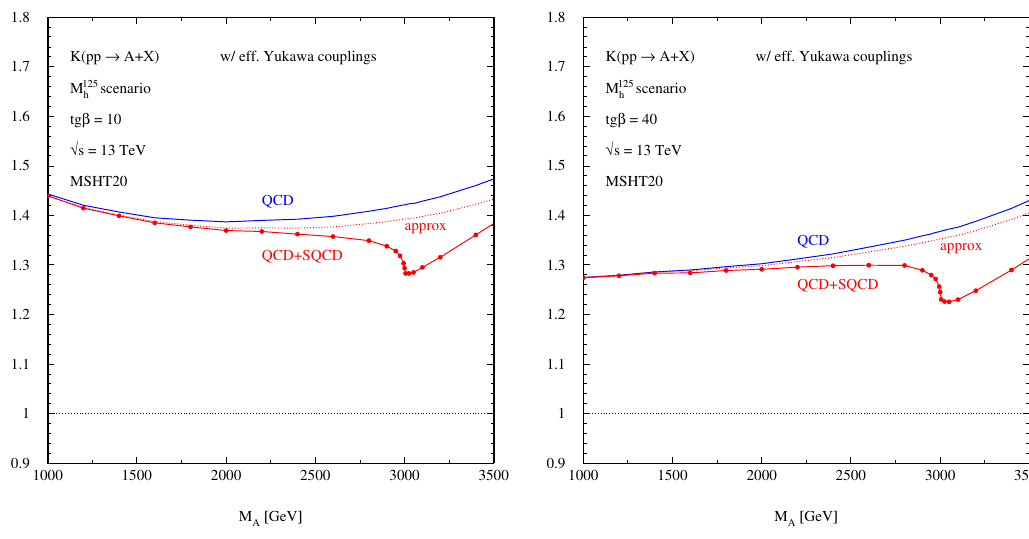
Figure 9 . The K-factors of the QCD and genuine SUSY-QCD corrections for the LHC with tg β = 10 , 40 and a c.m. energy of 13 TeV. As parton density functions the MSHT20 sets have been used. The renormalization and factorization scales have been chosen as µ R = µ F = M A / 2 .